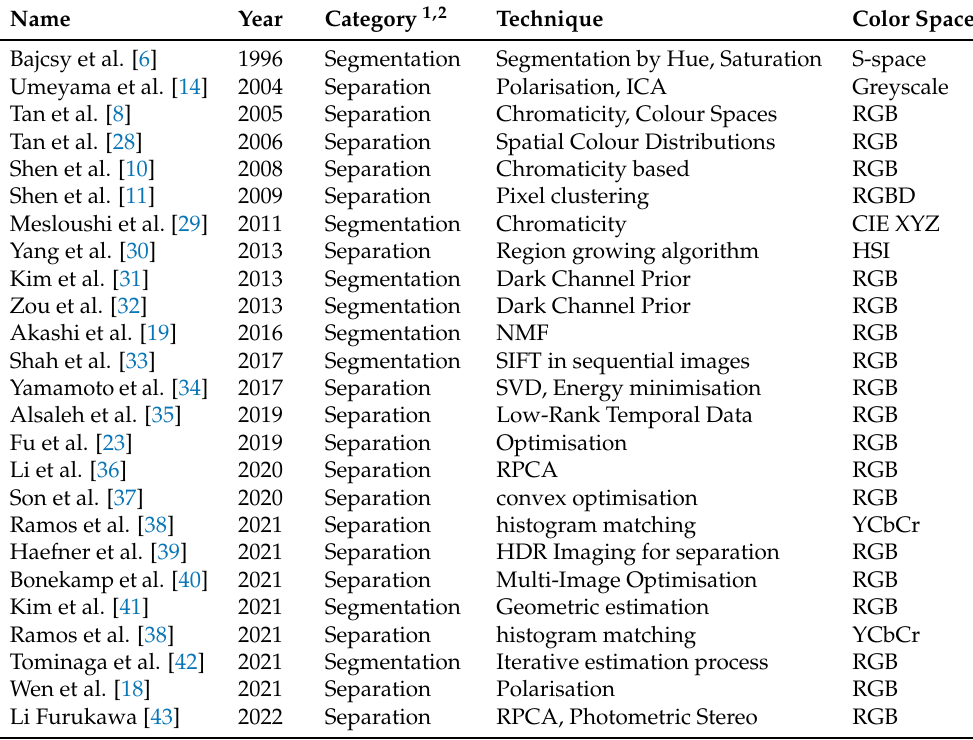
Table 1. Summary of major non-deep learning based methods for specular highlight